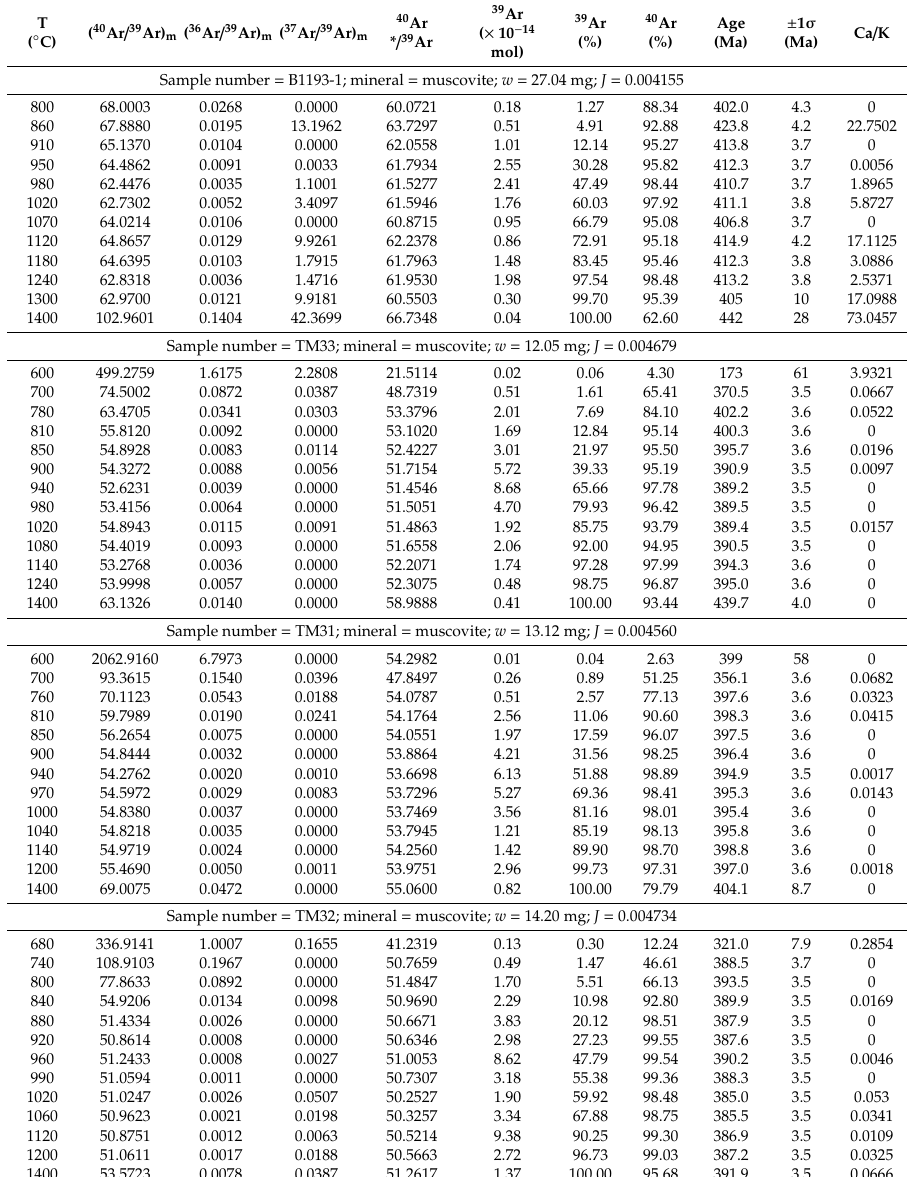
Table 2. 40 Ar / 39 Ar step-heating geochronology data for muscovite from garnet muscovite schist, muscovite quartz schist (Jianshan Formation), and